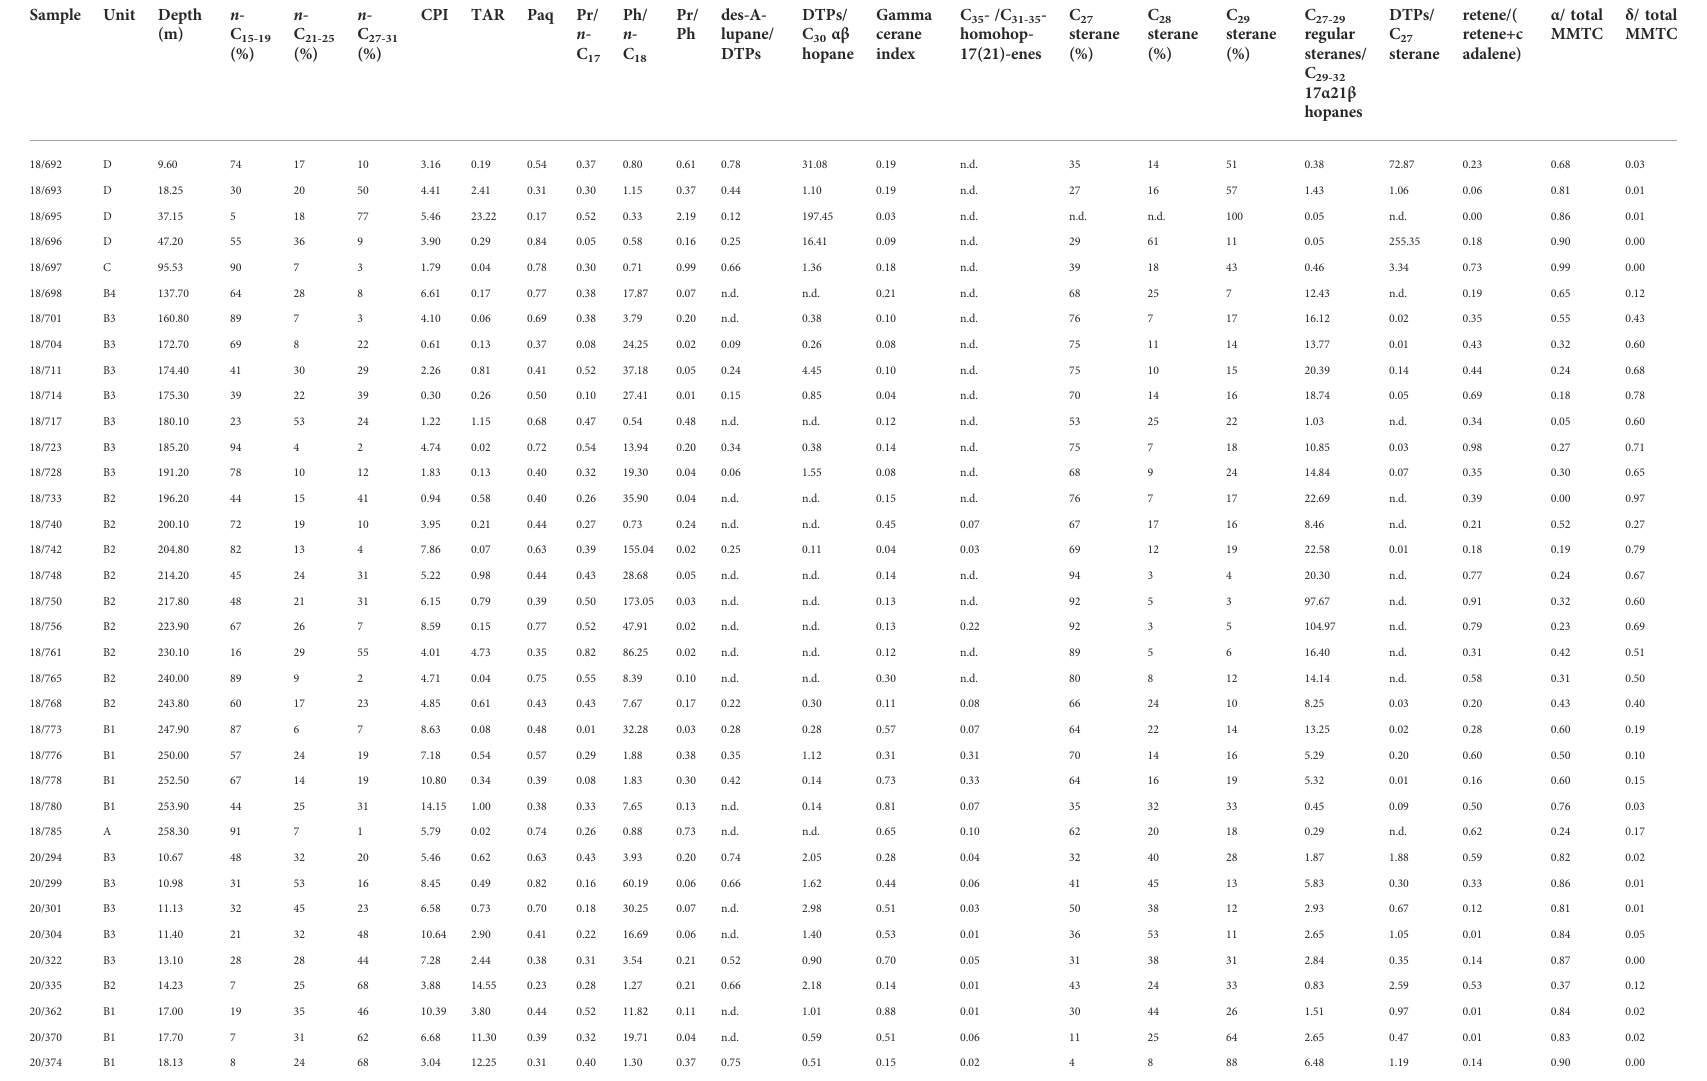
TABLE 2 Molecular geochemical parameters related to aliphatic and aromatic hydrocarbons of the post-impact sediments in the NR (CPI= carbon preference index, TAR= terrigenous/aquatic ratio, Paq=(n-C23+n-C25)/(n-C23+n-C25+n-C29+n-C31), Pr=pristane, Ph=phytane, n.d.=not determined; Sample Unit Depth